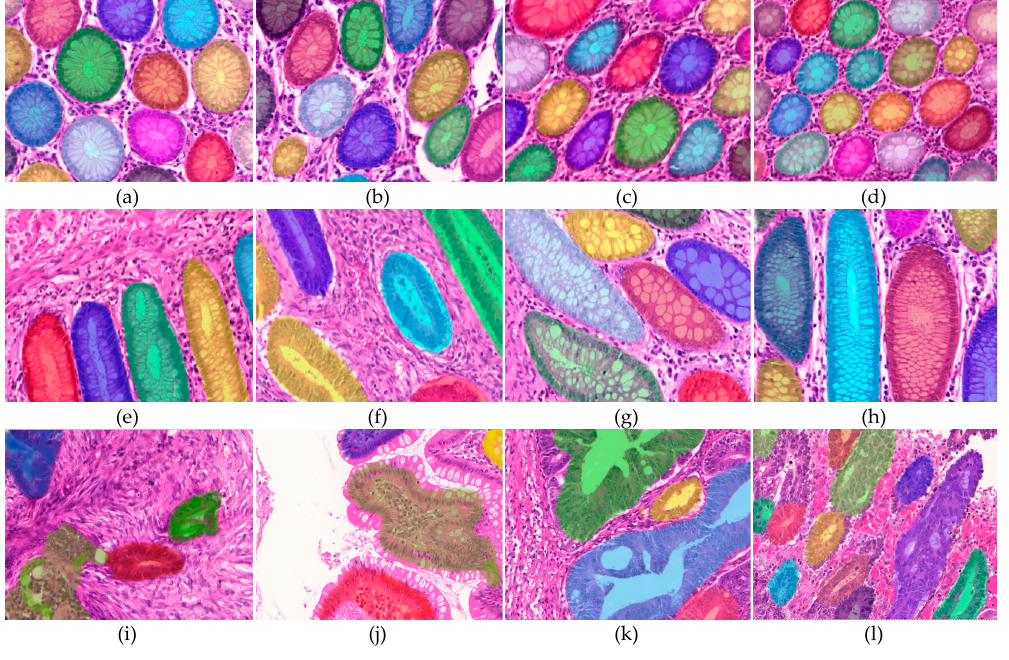
Figure 3. Example images showing the output of gland segmentation method. 1st row: normal samples, and 2nd and 3rd row: malignant samples of varying cancer grades. The method successfully captures the bounds of glandular regions and leads to good segmentation results for images in the 1st and 2nd rows despite the fact that images have huge variations and their glands appear in less regular structures. The third row shows example cases where the method could not identify boundaries of a few glands or has under-segmented (especially in the top-left corner of i and top-middle of j). All images were captured at 20 ×